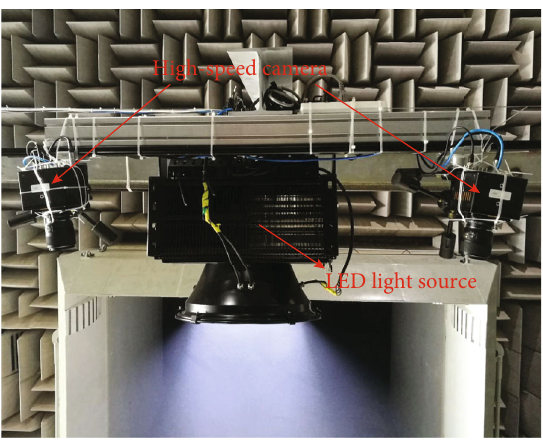
Figure 5: The imaging system.